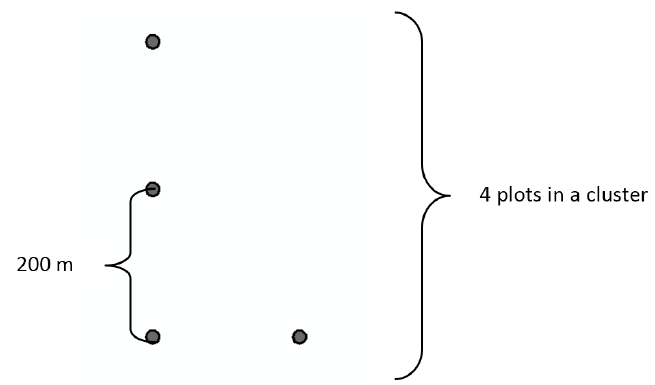
Figure 2. Plot layout in a cluster of four plots.